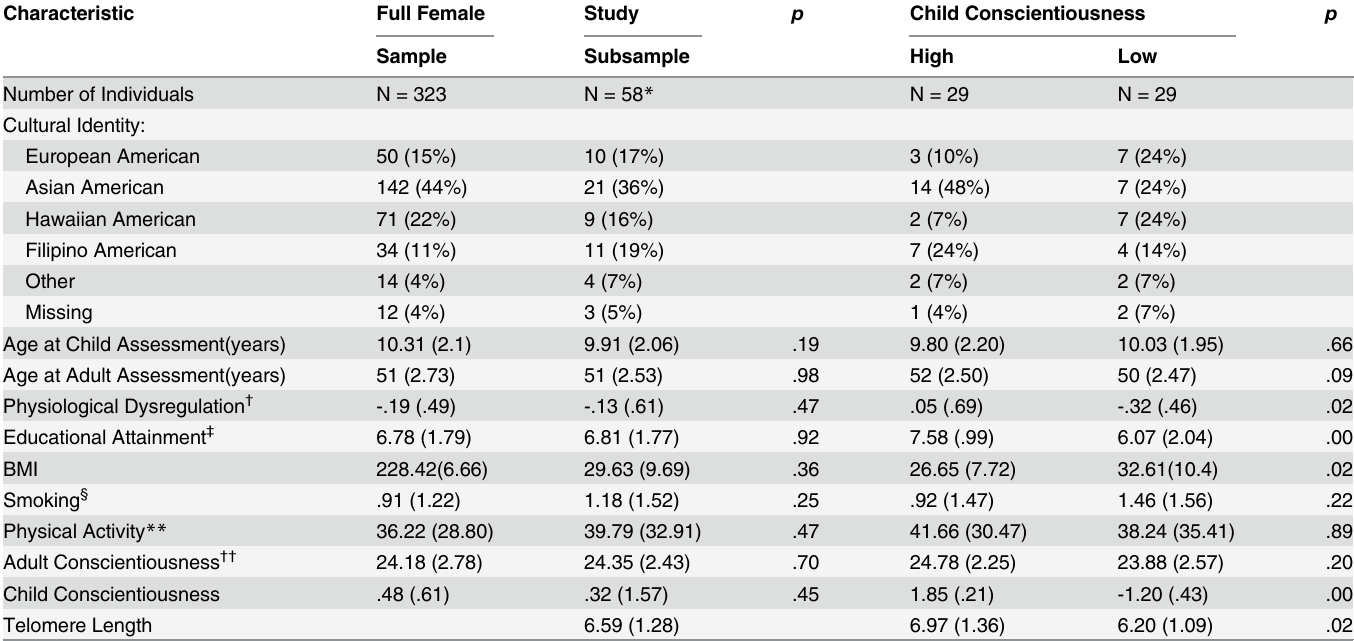
Table 1. Sample characteristics of the subsample in comparison to the female clinic sample and for the high versus low childhood conscientious- ness groups.